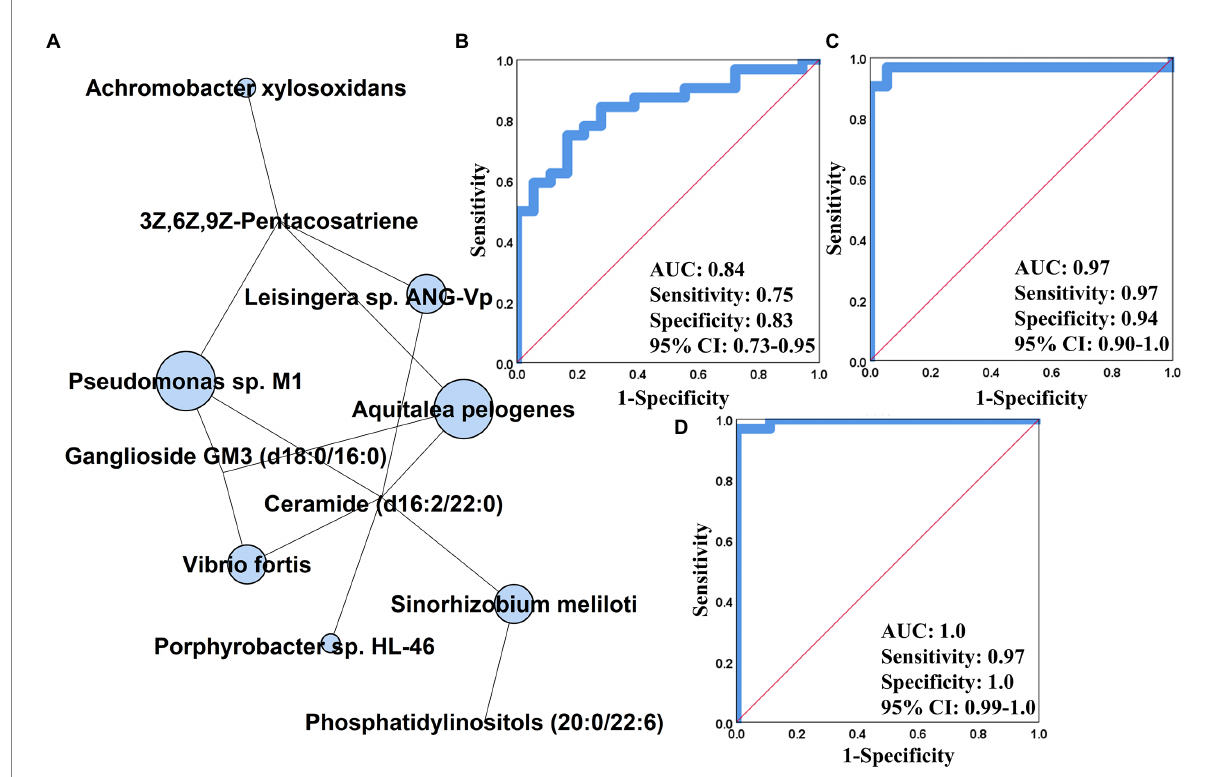
(D) constructed based on binary logistic regression model. AUC, the area under the curve; CI, confidence